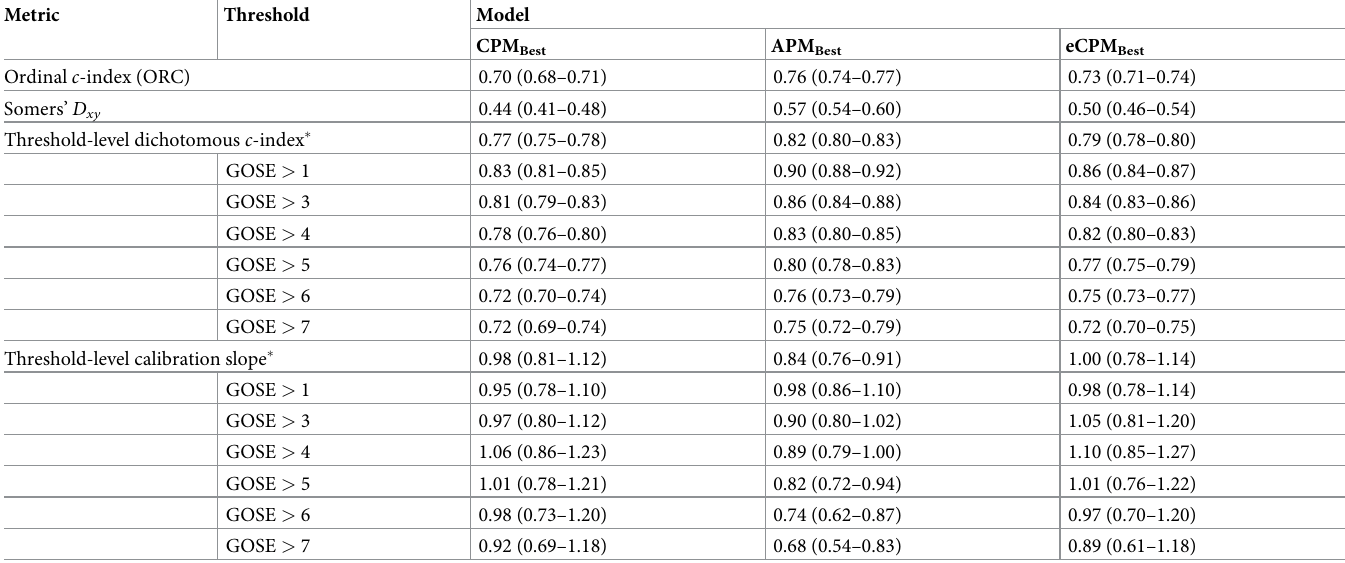
Table 4. Best ordinal model discrimination and calibration performance per predictor